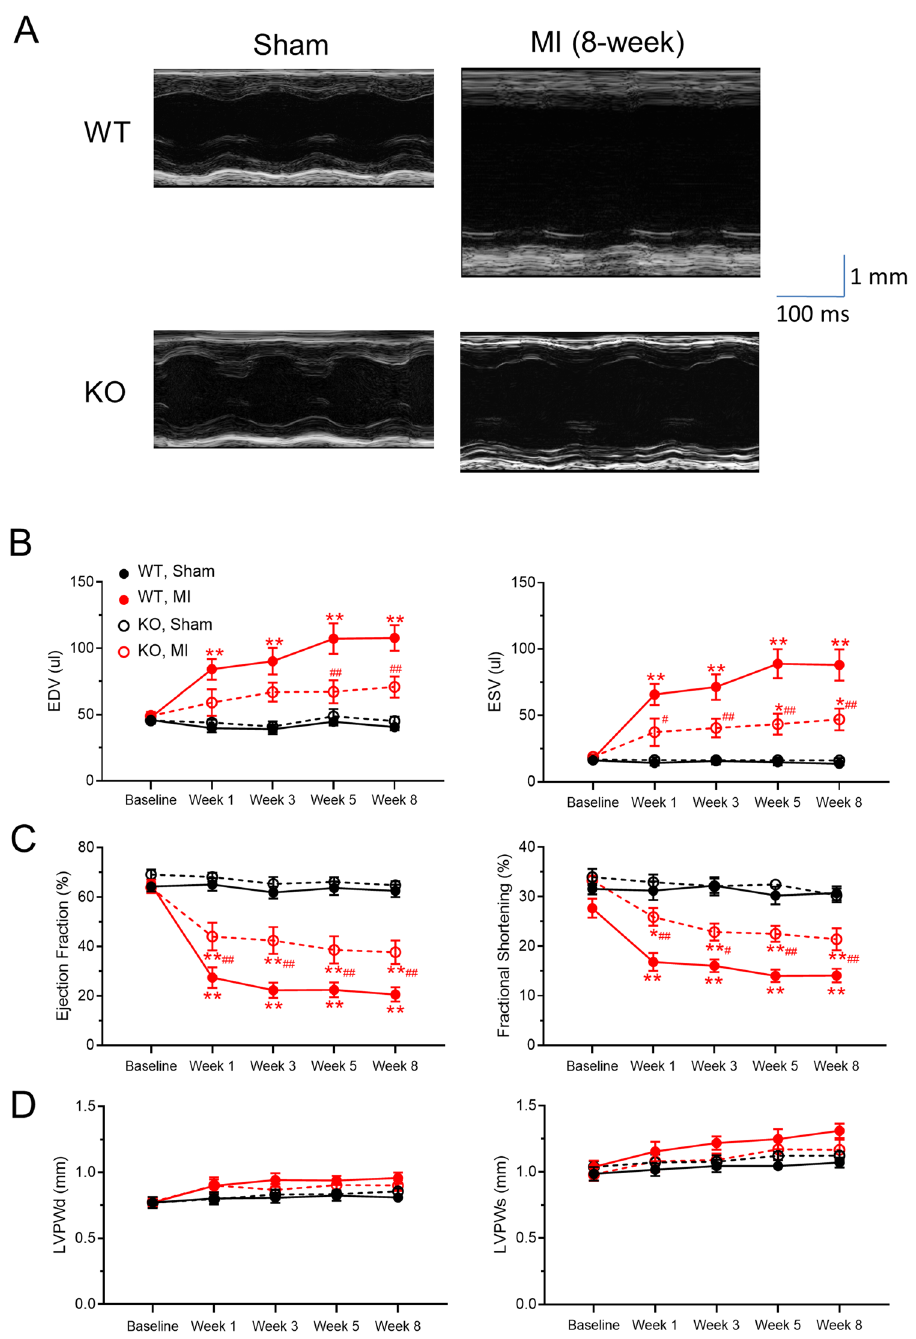
Figure 3. β-catenin knockout attenuates pump dysfunction and chamber dilation after myocardial infarction. ( A) Representative short axis, M-mode echocardiographic recordings at the left ventricular mid-papillary level showing attenuation of cardiac function and dilation in β-catenin KO mice post-MI. Echocardiogram was recorded when heart rates were in the 400–500 bpm range. ( B) to (D) Summary of echocardiographic parameters of mice up to 8 weeks after MI showing reduced left ventricular dilation in KO mice as measured by end diastolic volume (EDV, panel B, left) and end systolic volume (ESV, panel B, right), attenuation of cardiac systolic dysfunction in KO mice as measured by ejection fraction (panel C, left) and fractional shortening (panel C, right), and unchanged left ventricular posterior wall thickness at diastole (LVPWd, panel D, left) and at systole (LVPDs, panel D, right). n = 10–13 per group. * p < 0.05, ** p < 0.01, vs. corresponding sham groups; # p < 0.05, ## p < 0.01, vs. WT MI group at the indicated timepoints. Data were analyzed by two-way ANOVA and Bonferroni post-hoc